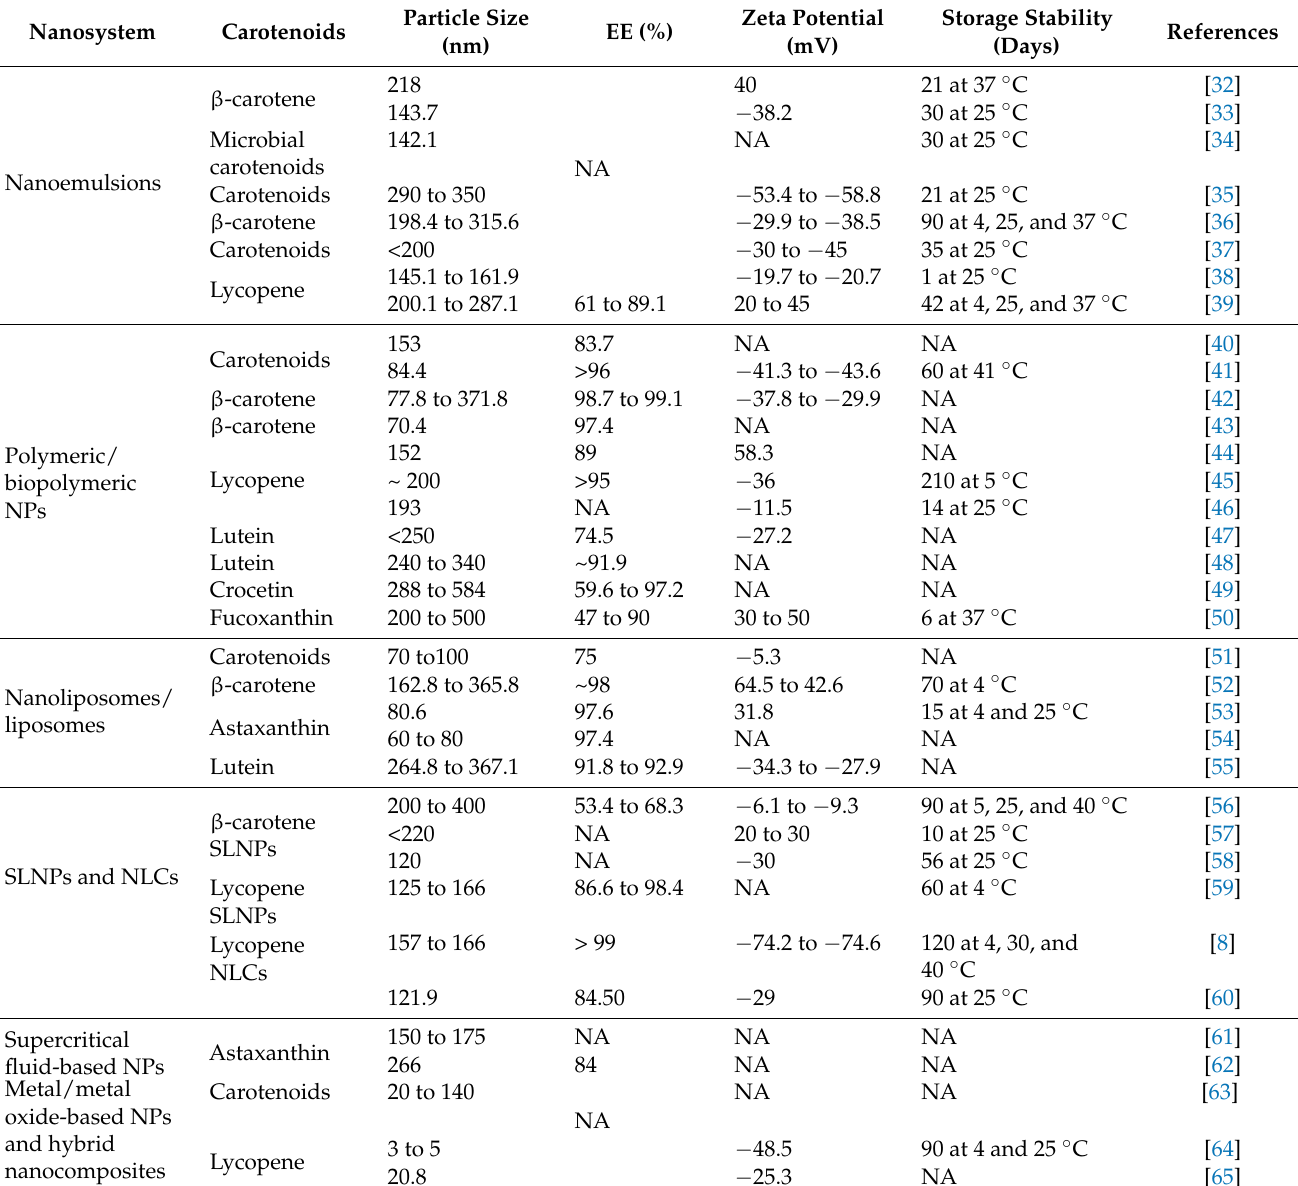
Table 1. Nanosystems for encapsulation of carotenoids 1